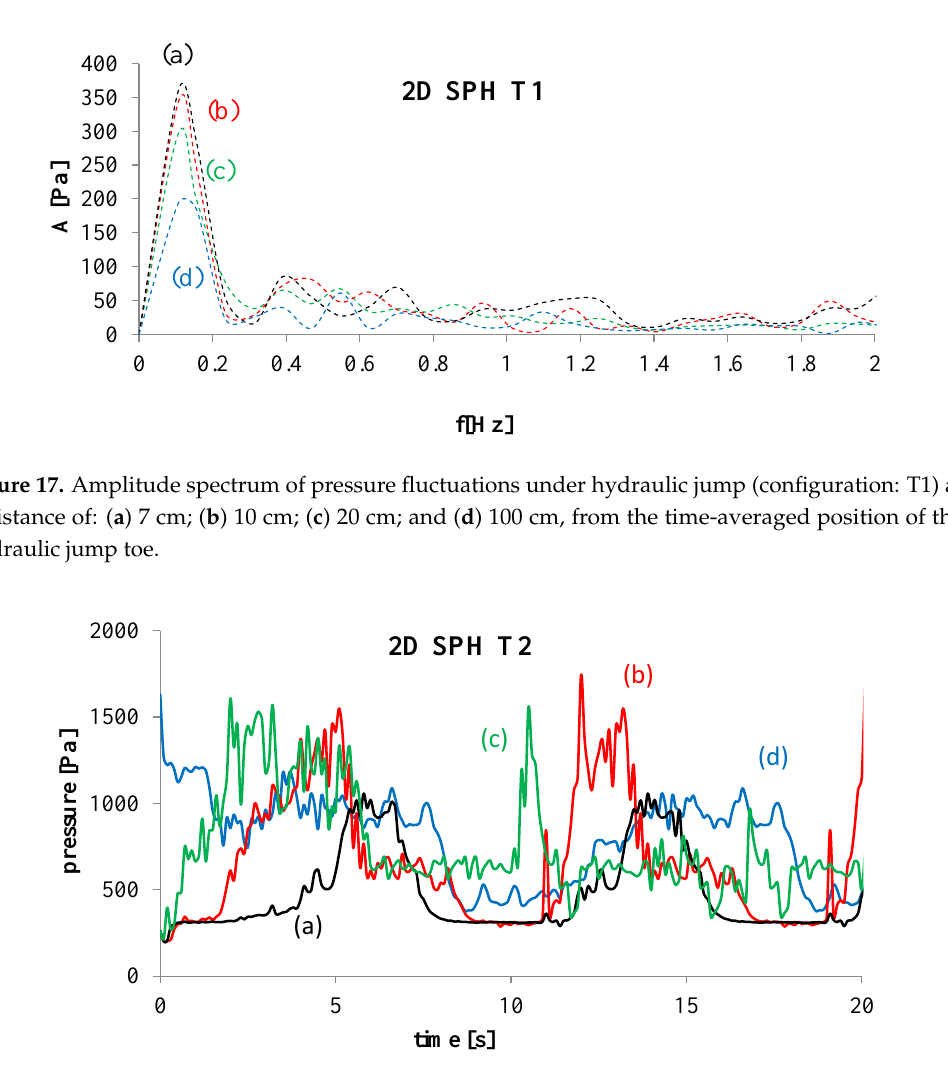
Figure 18. Time series of the pressure under hydraulic jump (configuration: T2) at a distance of: ( a ) 7 cm; ( b ) 10 cm; ( c ) 20 cm; and ( d ) 100 cm, from the time-averaged position of the hydraulic jump toe.